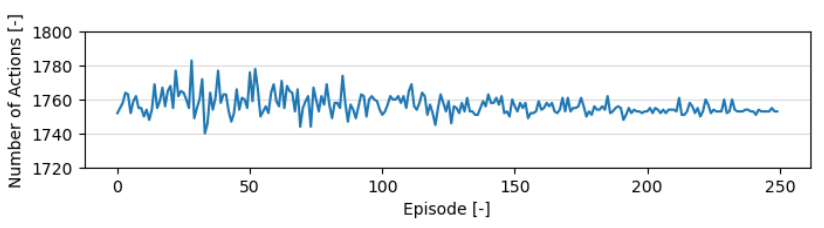
Figure 12. Number of calls to the RL agent per episode during